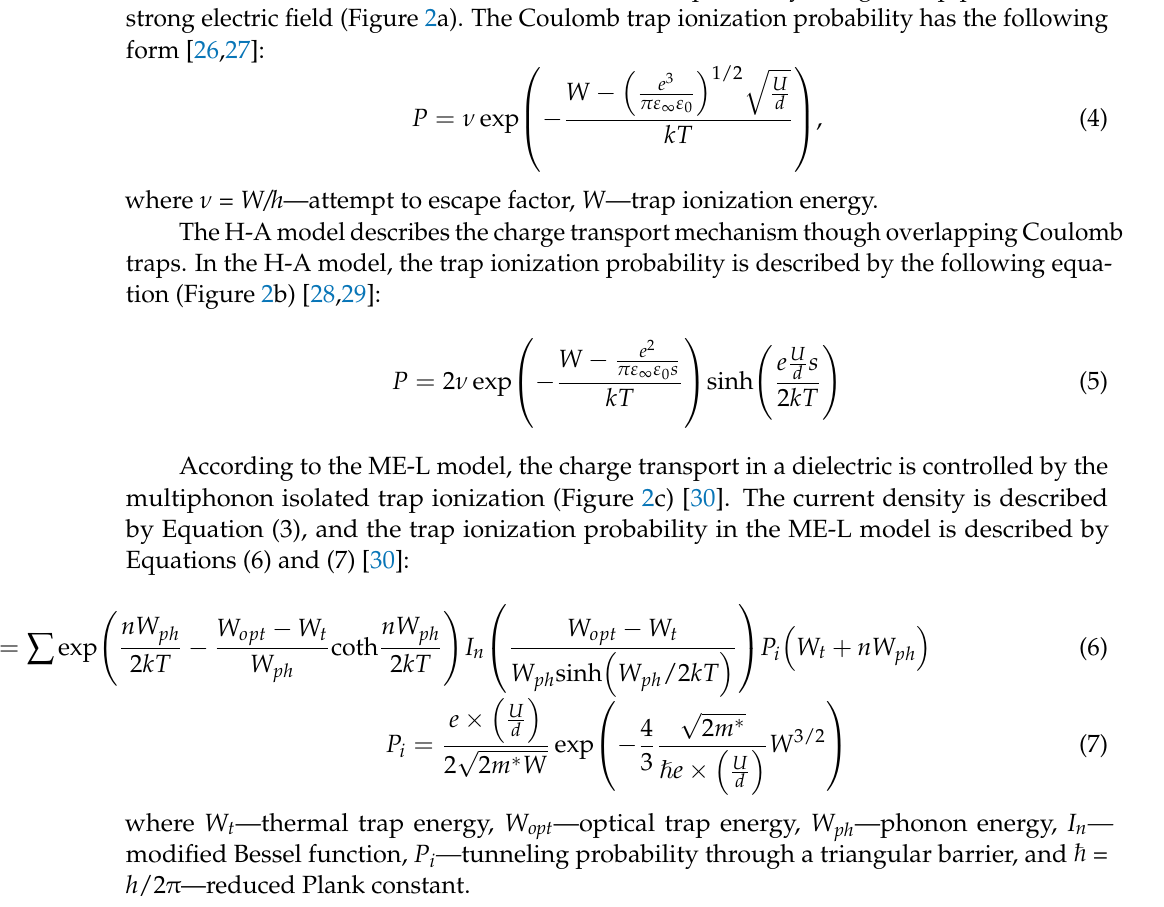
Figure 2. Schematic diagram of bulk-limited models: ( a ) Frenkel effect, ( b ) Hill–Adachi model of overlapping Coulomb potentials, ( c ) Makram–Ebeid and Lannoo multiphonon isolated trap ionization model, (d) Nasyrov–Gritsenko phonon-assisted tunneling via neighboring traps